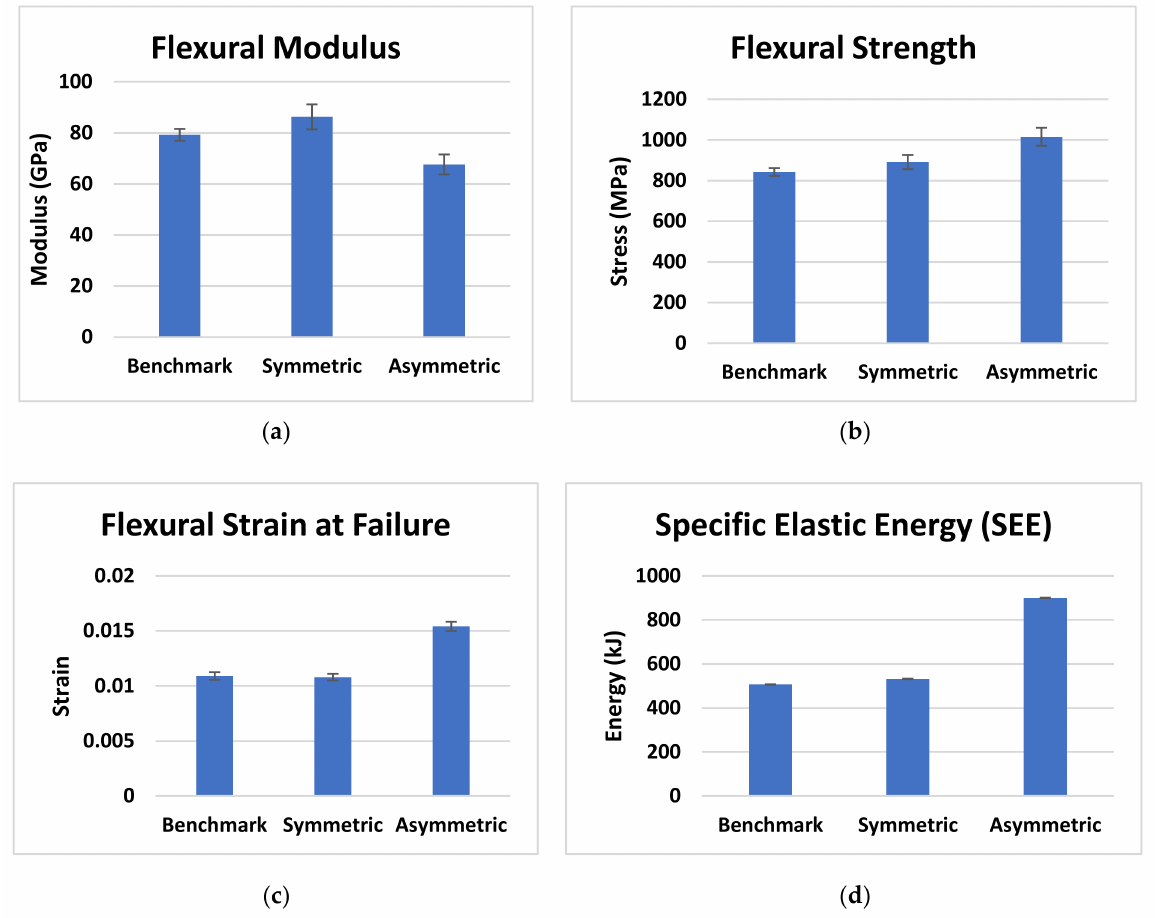
Figure 8. Bar plot results for the benchmark, FGPS and FGPA configurations: ( a ) flexural modulus; ( b ) flexural strength and ( c ) flexural strain at maximum force value; and ( d ) Specific Elastic Energy